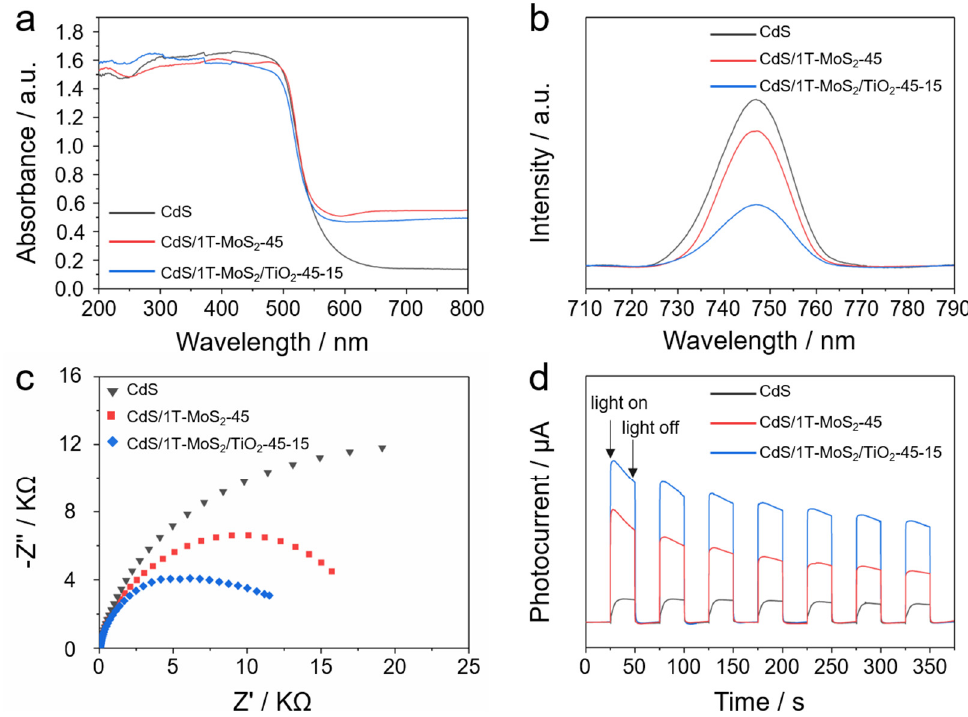
Figure 5. ( a ) UV-vis diffuse reflectance spectra (DRS), ( b ) photoluminescence (PL) spectra, ( c ) electrochemical impedance spectroscopy (EIS), and ( d ) transient photocurrent of the bare CdS, CdS/1T-MoS 2 -45, and CdS/1T-MoS 2 /TiO 2 -45-15 sam- ples.